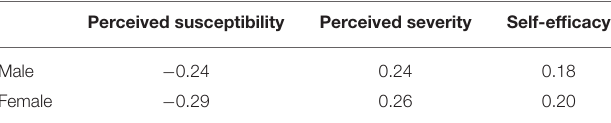
TABLE 5 | Coefficients of each dimension directly related to children’s medication adherence between parents of different places of